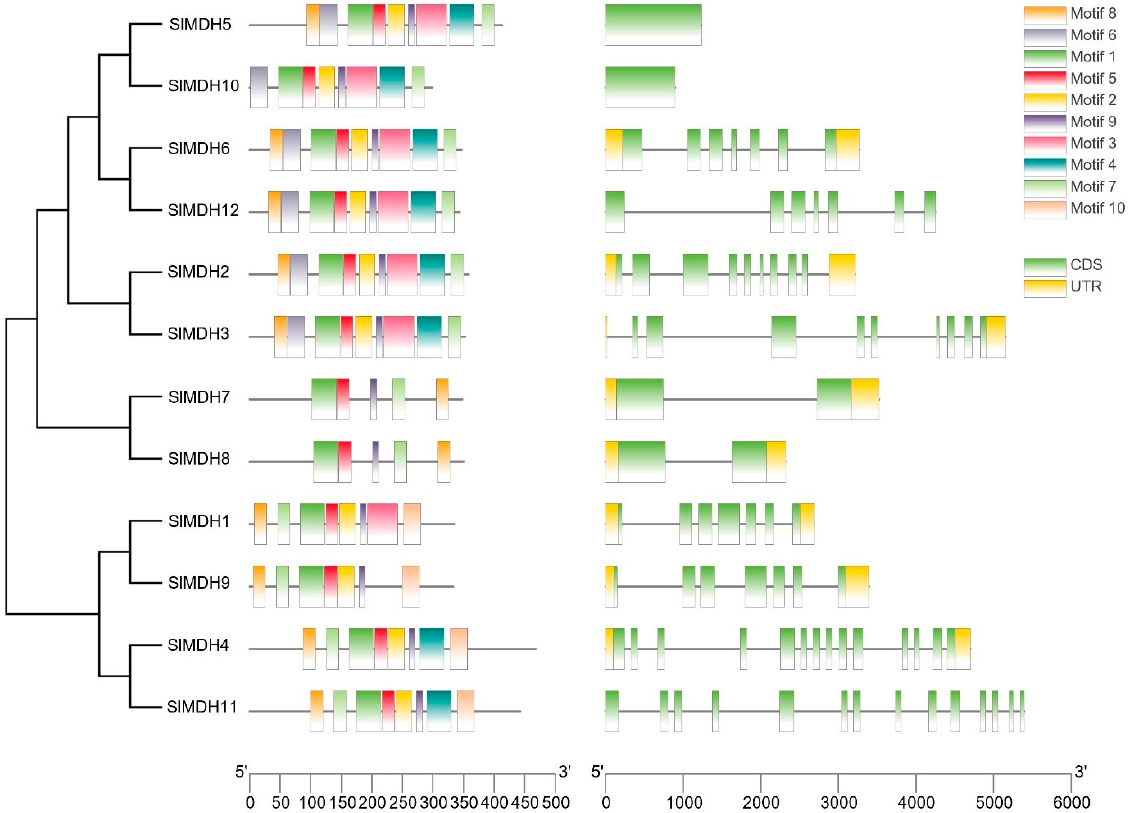
Figure 3. Motif identification ( left panel ) and gene structure ( right panel ) analysis of tomato MDHs. Each motif is shown in a different color. The intron/exon structure of tomato MDH genes. Exons and introns are shown by green boxes and grey lines, respectively.